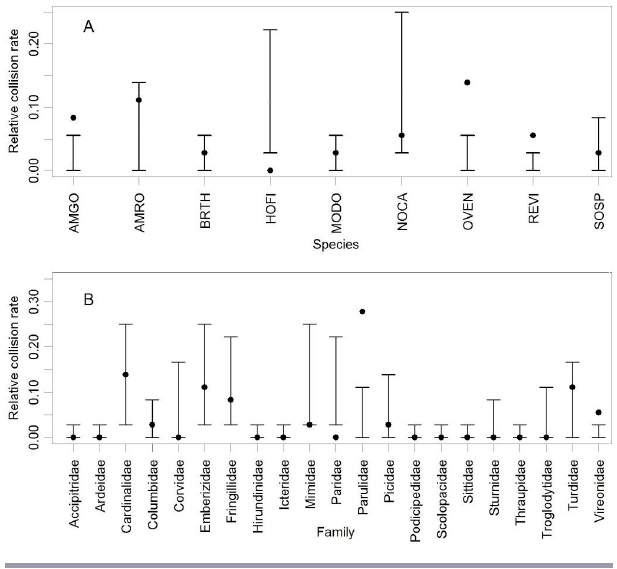
Fig. 3 . Confidence intervals (bars) and observed rates (dots) for (A) 9 species. The following species were omitted with a lower confidence interval equal to zero and no collisions during the Spring and Fall 2015 Duke collision surveys: AMCR, BAWW, BHCO, BHNU, BLJA, BLWB, BTNW, CACH, CARW, DOWO, EATO, EUST, GBHE, GRCA, HAWO, HETH, NOFL, NOMO, NRSW, PBGR, PIWA, RBWO, ROPI, RTHA, SCTA, SPSA, TUTI, UYRW, WBNU, WOTH, and WTSP (see Table 2 for AOU codes). (B) 21 families observed during campus point count survey.